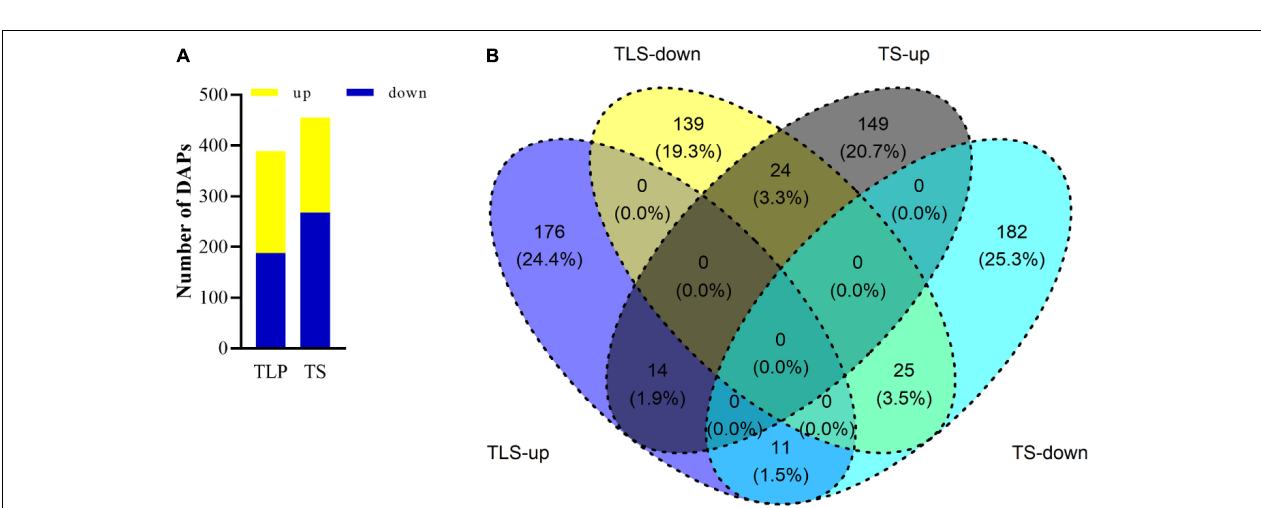
FIGURE 3 | The number of up-regulated and down-regulated DAPs in two different growth stages (A) . Venn diagram showed the overlaps of the DAPs in in different growth stages (B) . TLS-up represented the three-leaf stage up-regulated proteins; TLS- down represented the three-leaf stage down-regulated proteins; TS-up represented tillering stage up-regulated proteins; TS-down represented tillering stage down-regulated proteins.